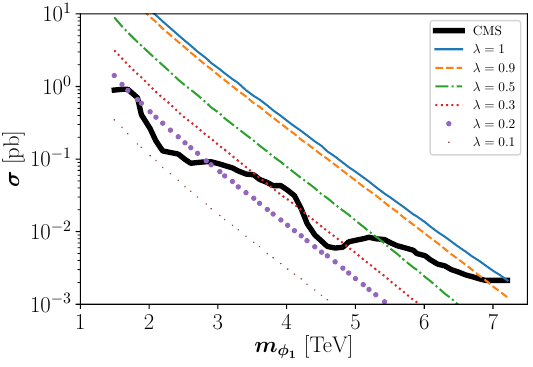
Figure 5 . The solid black curve represents the CMS [28] observed 95% CL upper limits on produc- tion cross section times branching fraction as function of di-jet resonance mass. Those limits are compared to the predicted cross sections of pp of m (cid:30) and for di(cid:11)erent values of the coupling 0 : 1 < (cid:21) < 1. These predictions are represented by 1 the colored curves.